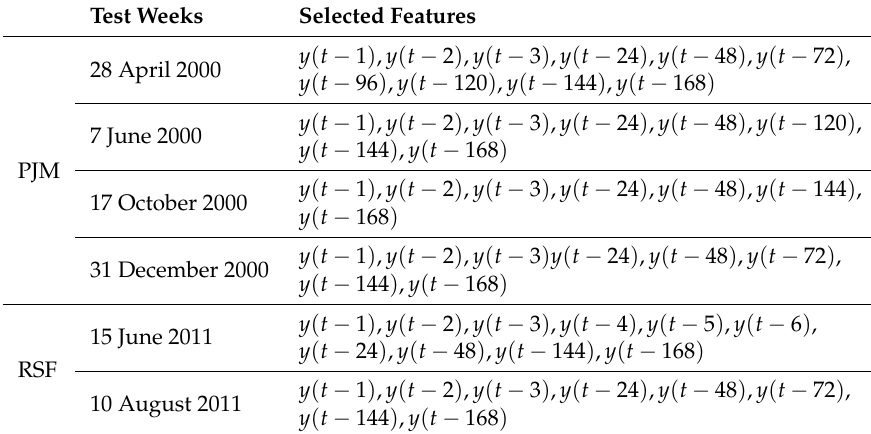
Table 1. The selected features for four training sets and test